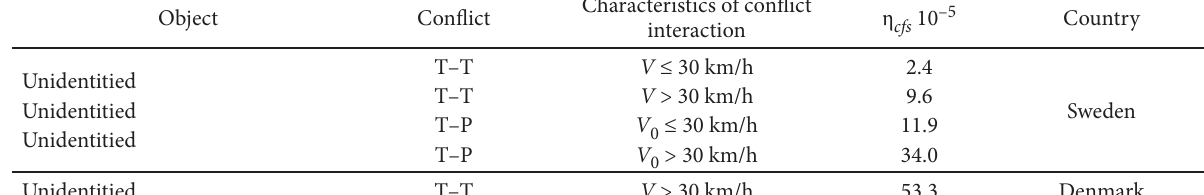
Characteristics of conflict η cfs 10 –5 interaction